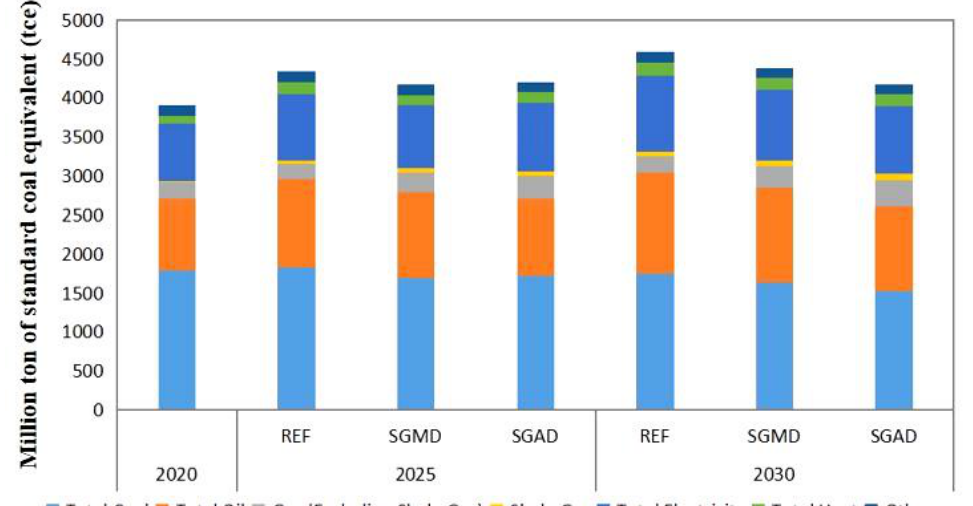
Figure 4. Final energy consumption.